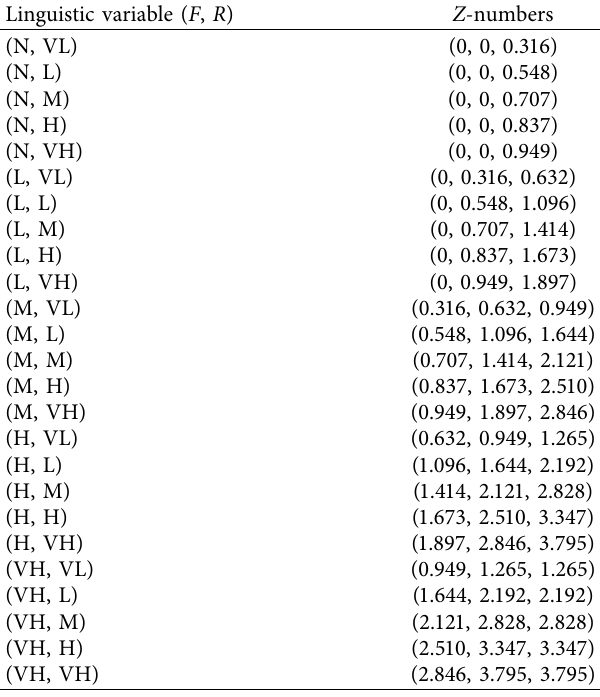
Table 1: Evaluation scales of Z -DEMATEL and corresponding membership functions